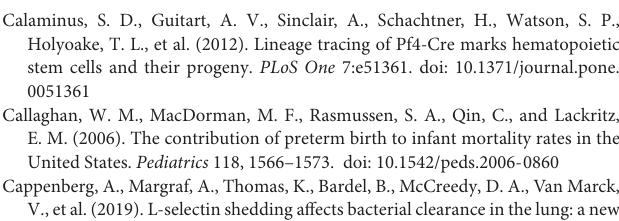
Supplementary Figure 1 | Measurements of imaging stage. Supplementary Figure 2 | Measurements of holding device. Supplementary Figure 3 | Measurements of incised petri dish. Supplementary Figure 4 | Exemplary imaging